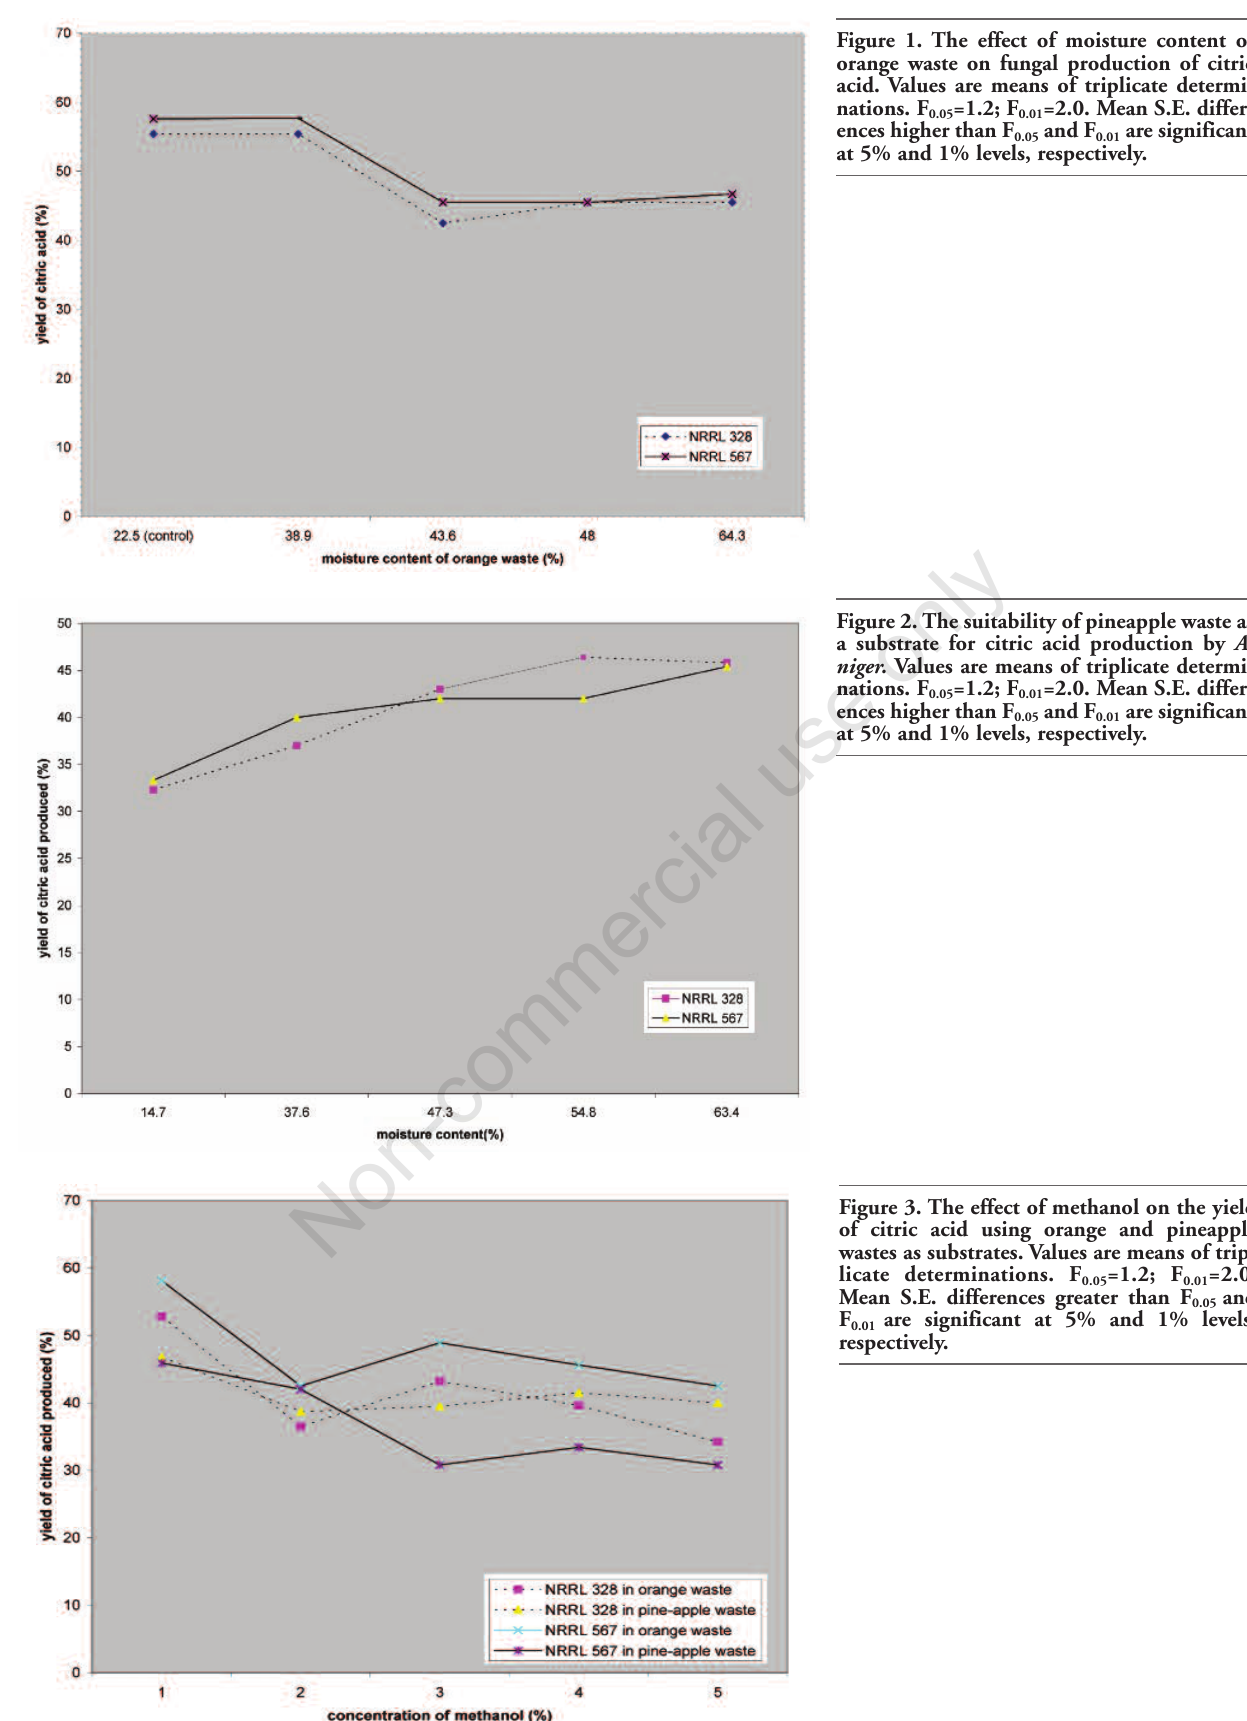
=1.2; F =2.0. 0.05 0.01 and 0.05